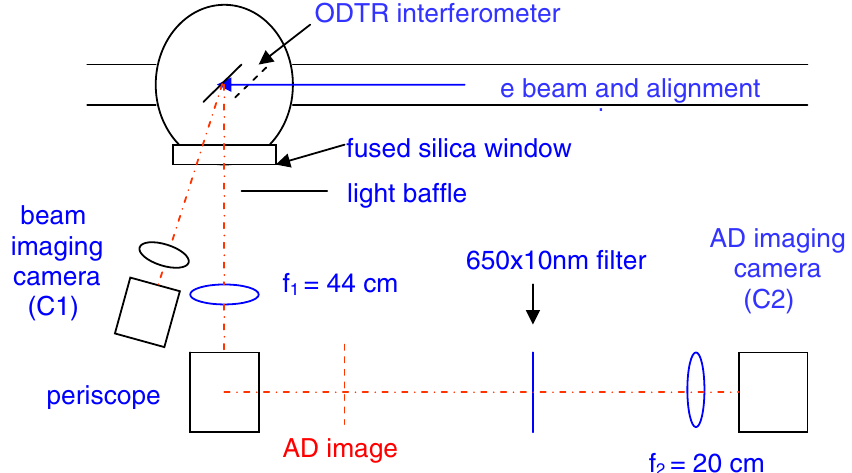
FIG. 7. (Color) Top view of experimental setup at BNL/ATF showing beam line, vacuum vessel, interferometer, and